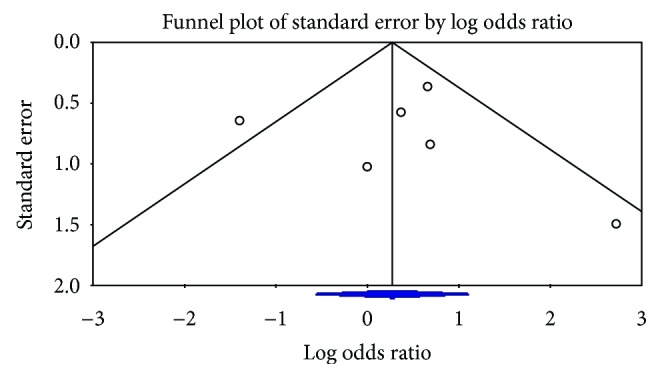
Funnel plot for publication bias.